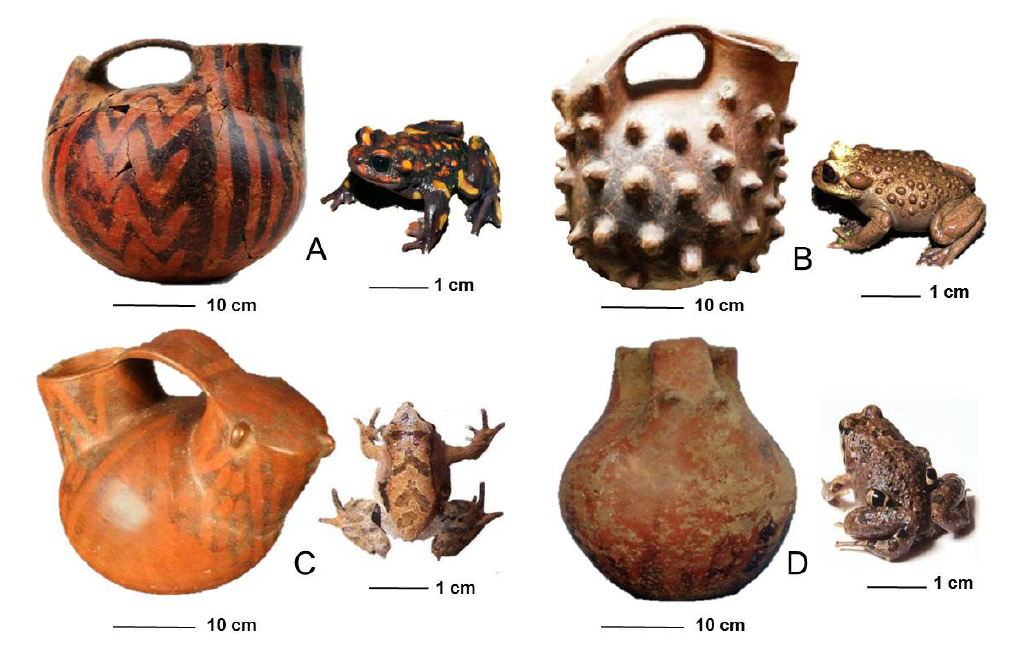
Figure 4. Vessels representing amphibian species: A- Telmatobufo venustos, B- Telmatobufo bullocki , C- Rinhoderma darwinii , D- Pleuroderma